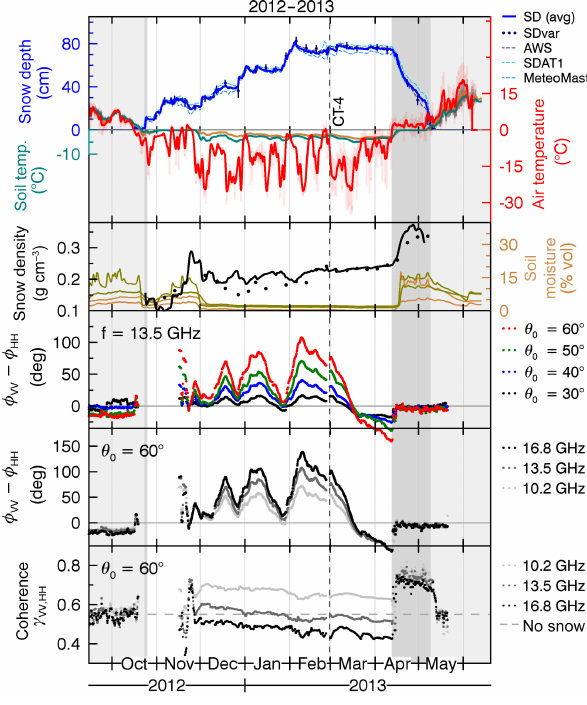
Figure 9. Winter season 2012–2013. Meteorological and radar data as shown in Fig. 6 and described in Sect. 4.6. The vertical dashed line shows the date when the snow profile CT-4 was